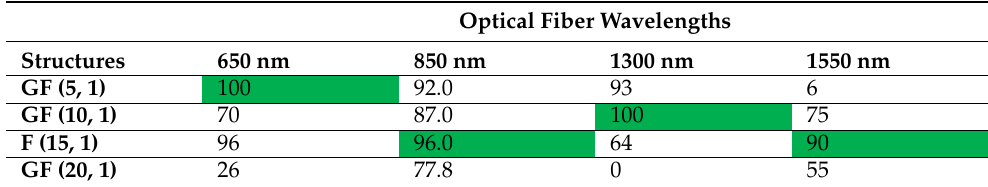
Table 1. Transmittance (%) for optical fiber wavelengths using the 3 rd iteration of GF ( m , 1) struc- tures.